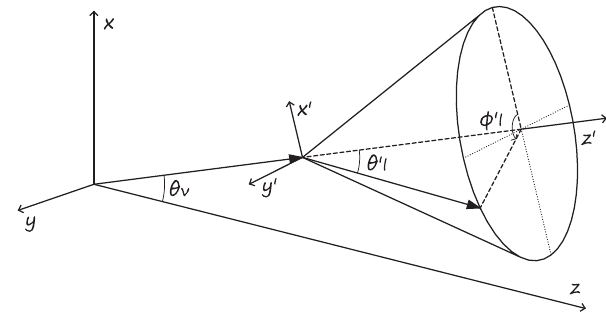
FIG. 13. Reference frame of the near detector (and the neu- trino beam) xyz and frame of the neutrino-electron scattering x 0 y 0 z 0 ( z 0 is along with the neutrino